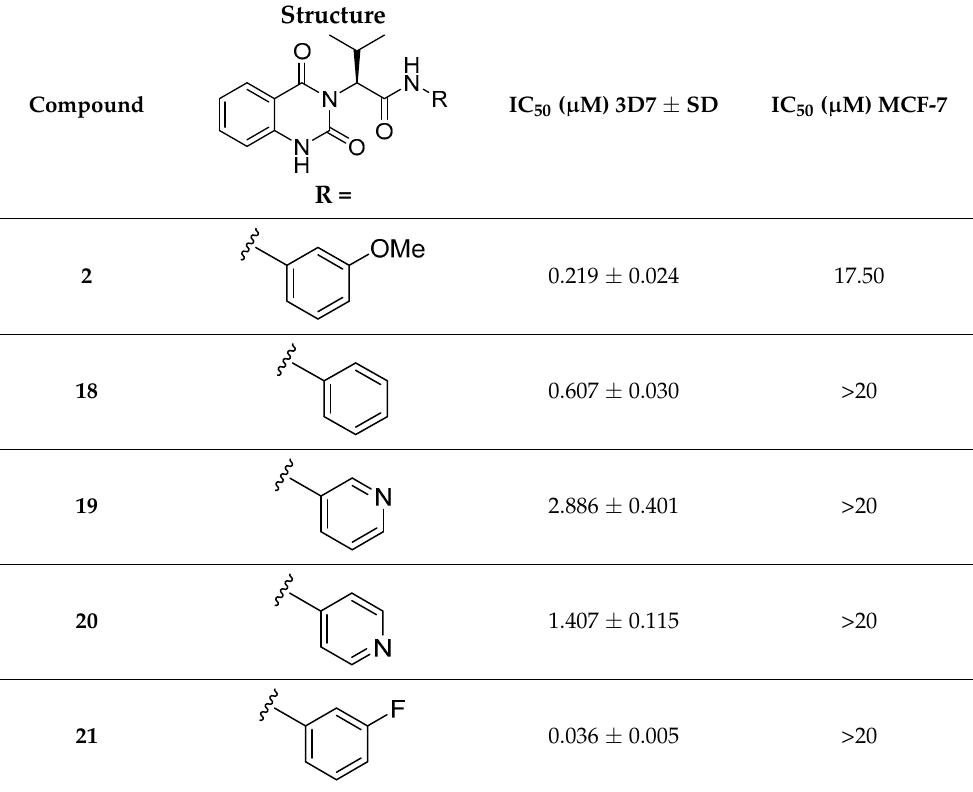
Table 3. In vitro antimalarial activities against P. falciparum 3D7 and cytotoxicity against MCF-7 cells of quinazolinedione derivatives with various amine side chains.